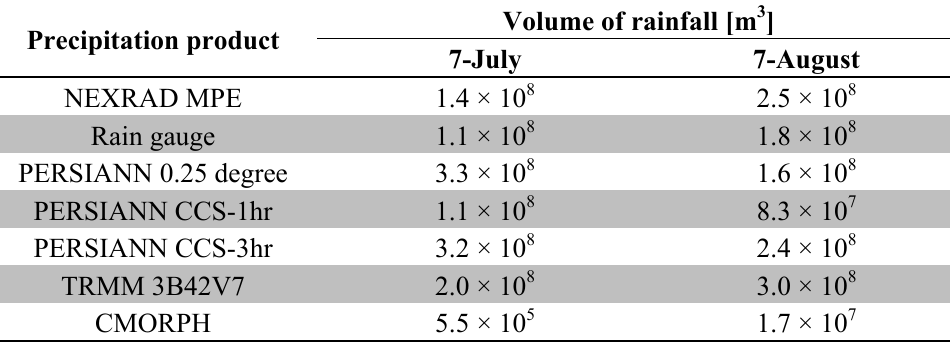
Table 6. Volume of rainfall amounts over the study